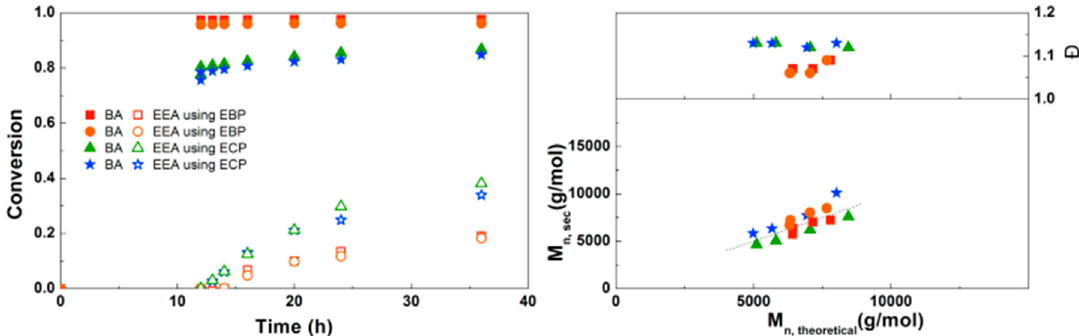
Figure 8. ( Left ): conversion versus time plot for Cu(0)-mediated one-pot block copolymerization of BA and EEA using [BA]:[EEA]:[EBP]:[Me 6 TREN]:[CuBr 2 ] = 50:50:1:0.15:0.1 and [BA]:[EEA]:[ECP]:[Me 6 TREN]:[CuCl 2 ] = 50:50:1:0.15:0.1, 3.0 M in DMF at 25 °C and 12.5 mm 2 /mL Cu(0) wire. A 3.0 M solution of EEA in DMF was added after 12 h reaction time. ( Right ): corresponding molecular weight and dispersity versus theoretical molecular weight plot.